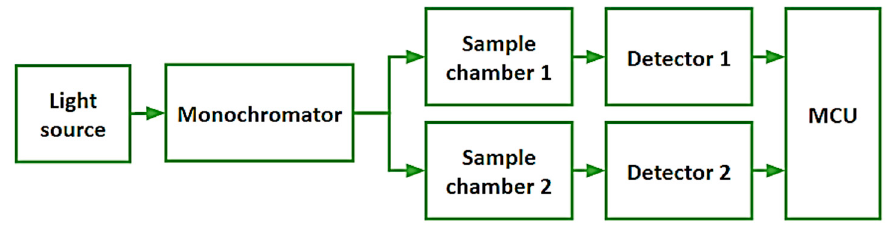
Figure 1. System architecture of the developed spectrophotometer.